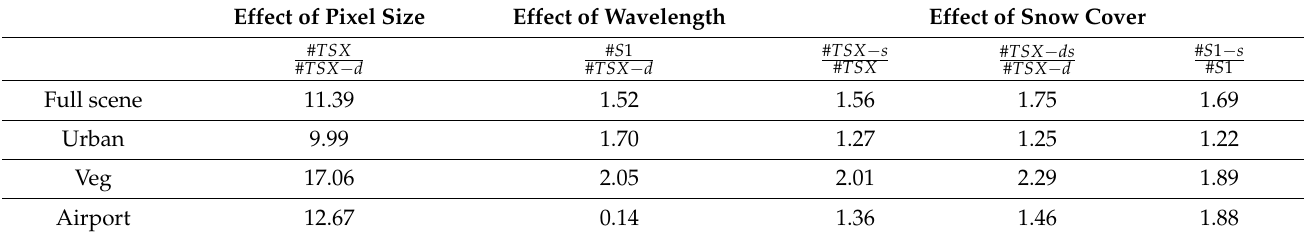
Table 2. The ratio of PS